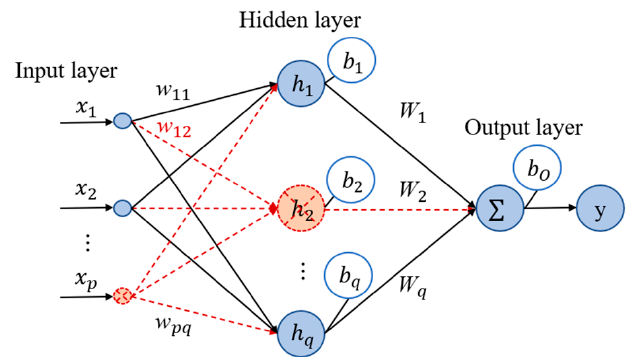
Figure 2. Schematic of dLASSO-MLP .